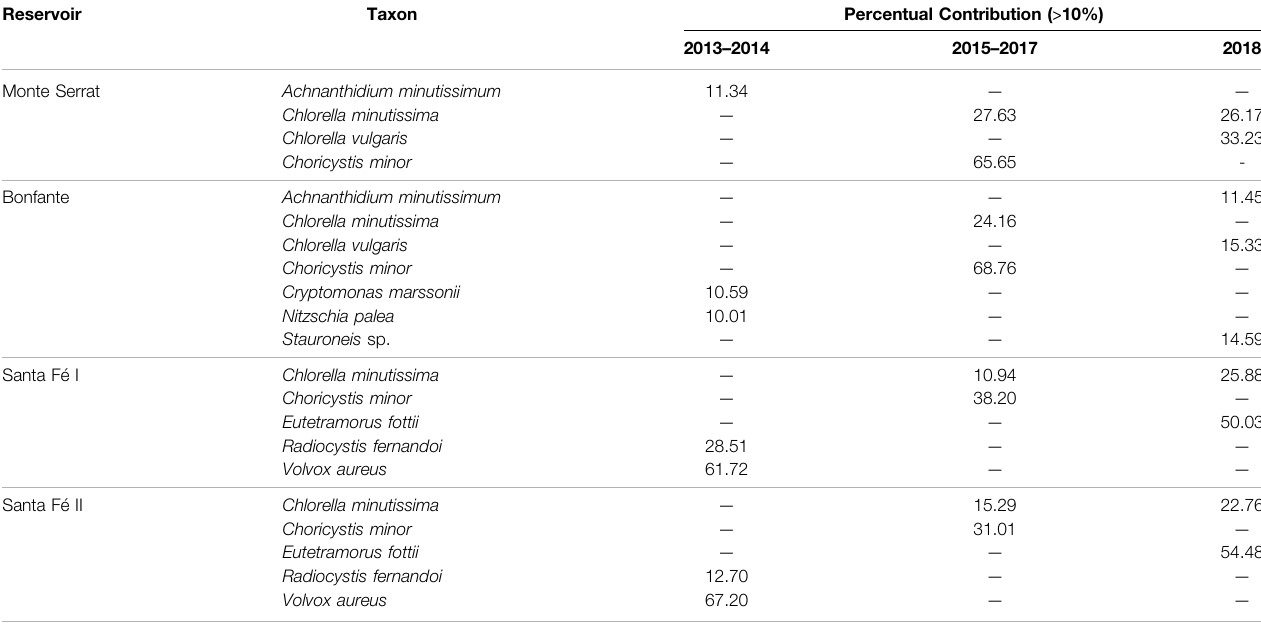
TABLE 2 | Density contribution of the main phytoplankton species in the Monte Serrat, Bonfante and SantaFé reservoirs, considering the periods between 2013and 2014, 2015 – 2017 and 2018. Only contributions greater than 10% were considered. Reservoir